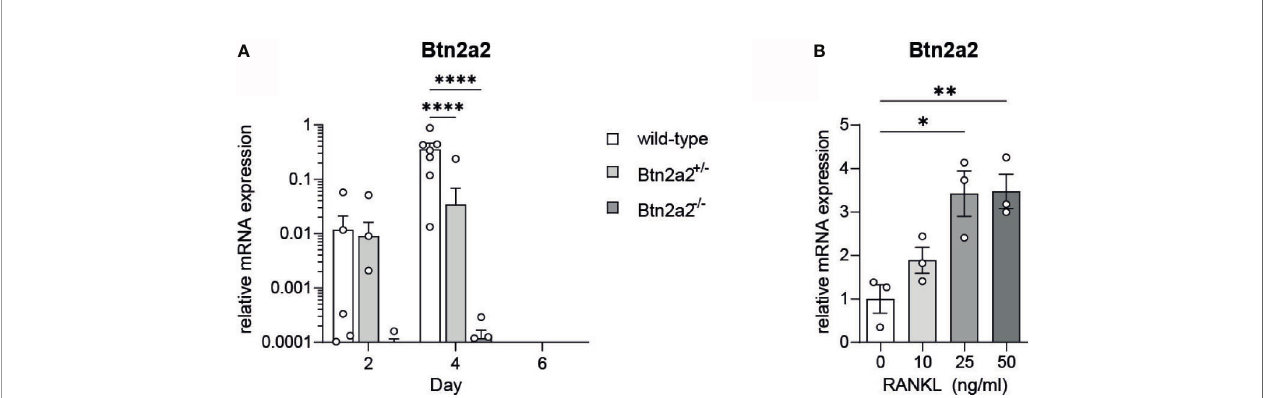
FIGURE 1 | Btn2a2 is regulated during osteoclastogenesis in a RANKL-dependent manner. (A) Btn2a2 expression was analyzed by quantitative RT-PCR at days 2, 4 and 6 during osteoclast assay from Btn2a2-/- , Btn2a2+/-, and wild-type littermate controls. Relative expression values normalized to the housekeeping gene GAPDH are shown. (B) Quantita tive RT-PCR for determination of relative mRNA levels of Btn2a2 normalized on GAPDH, after 2 hours stimulation of osteoclast precursors with indicated RANKL concentrations. Data are representative of 2 independent experiments, with 3 mice per group. Signi fi cance was assessed using one- (B) or two-way ANOVA (A) and Bonferroni's post-hoc test. Data are shown as means± SEM. *P < 0.05; **P < 0.01. ****P <